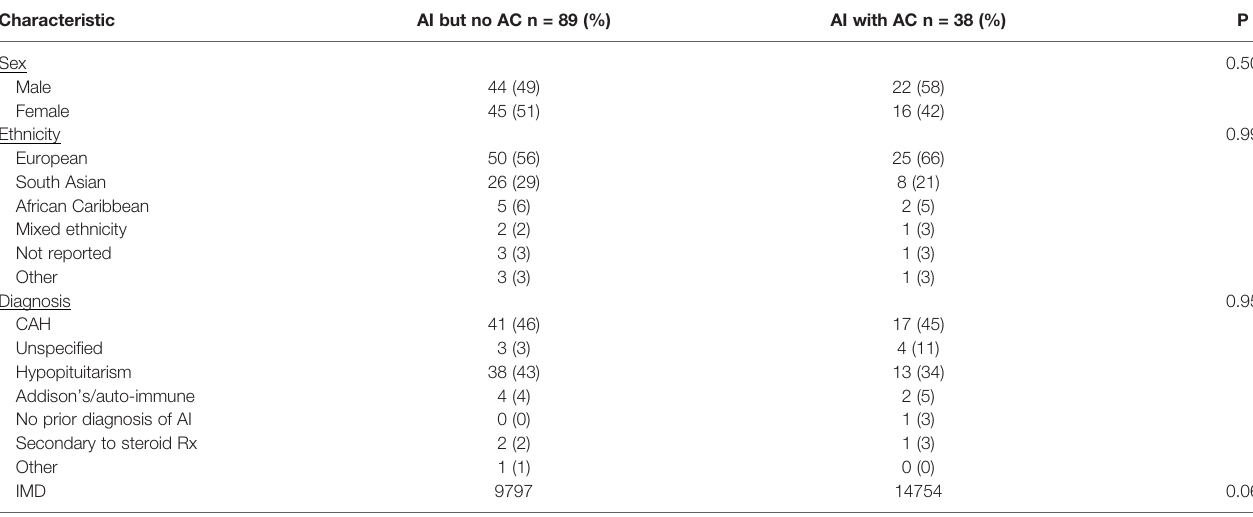
TABLE 2 | Demographics of AI patients with and without AC.